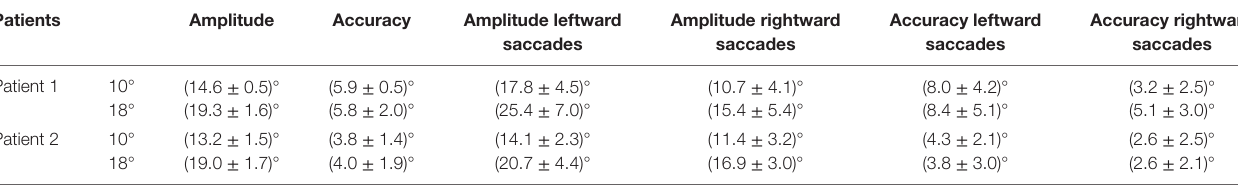
TaBle 2 | Saccade metric parameters estimated for all saccades in each experiment.